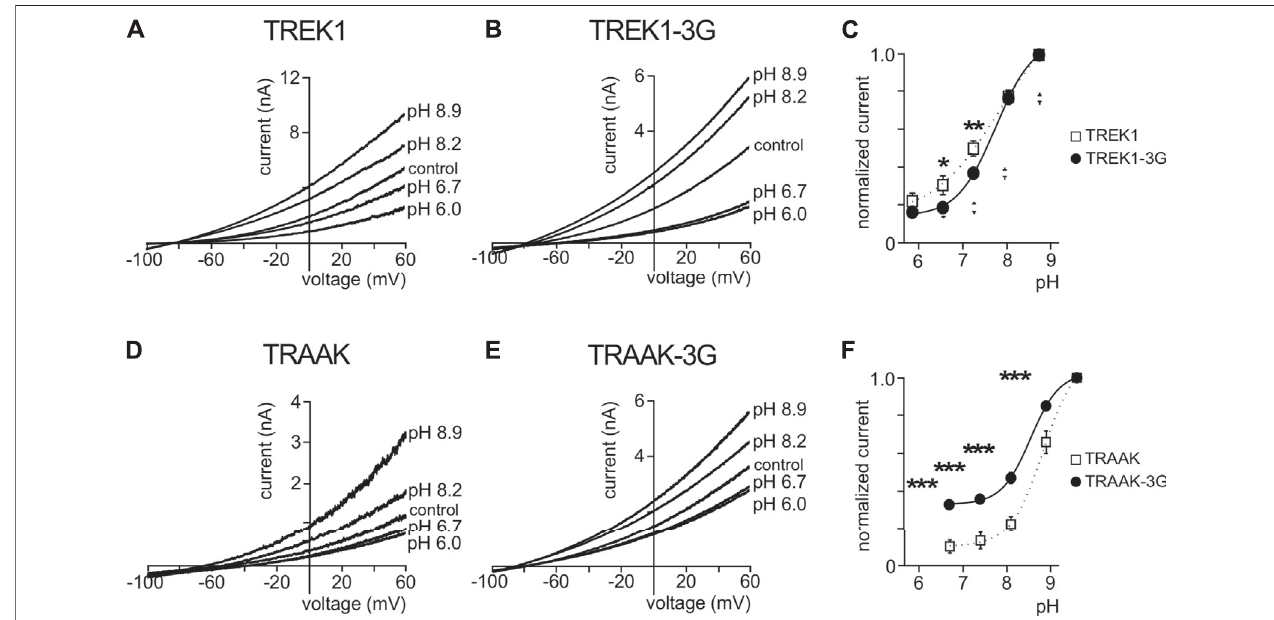
FIGURE 8 | Effect of extracellular pH. (A, B, D, E) , Representative patch-clamp recordings from HEK cells expressing wild-type or mutated channels. Voltage ramps were applied from − 100 to 60 mV from a holding potential of − 80mV. (C, F) , Normalized pH response (at 0 mV) for indicated channels. Data are presented as mean ± SEM. p p < 0.05, pp p < 0.01, ppp p < 0.001 (Two-way